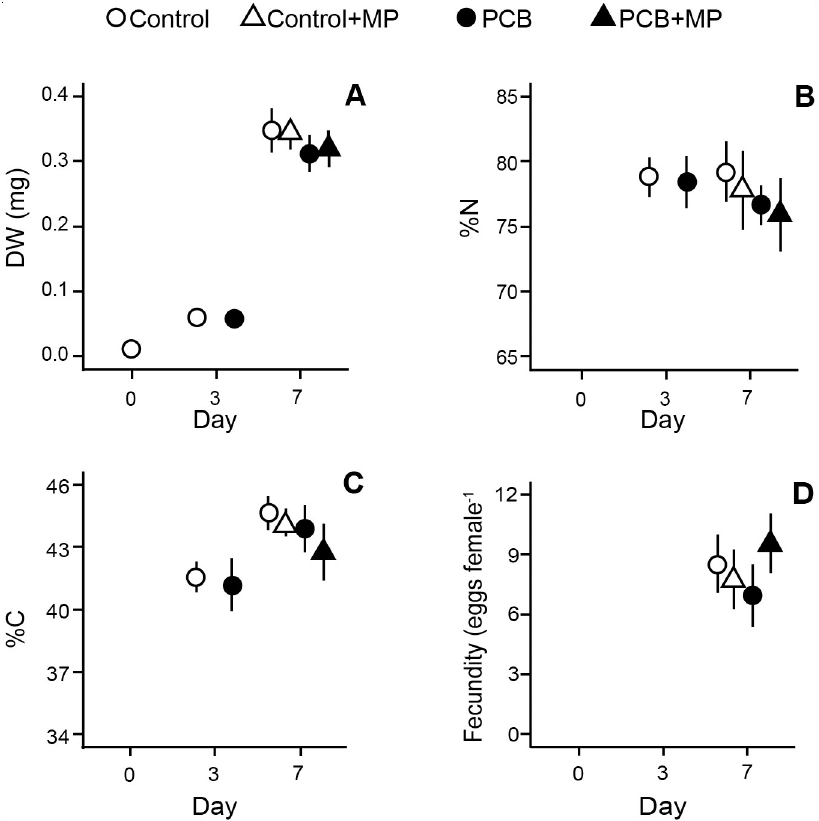
Fig 3. Treatment effects on the life-histories and body composition of D . magna . The life-history parameters and body composition on days 0, 3 (post accumulation phase) and 7 (post depuration phase): (A) individual body mass (DW), (B) carbon (%C) and (C) nitrogen content (%N), and (D) fecundity (eggs female -1 ). No eggs had been produced at the termination of the accumulation phase. Data are shown as mean ± SD. Some error bars are invisible due to the low